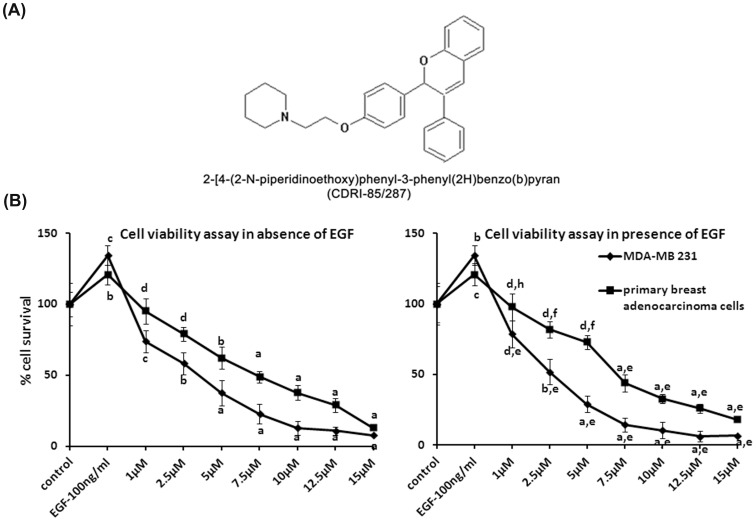
Anti-proliferative activity of CDRI-85/287 in ER-negative breast cancer cells.(A) Structure and molecular formula of CDRI-85/287. (B) CDRI-85/287 suppresses the growth of ER-negative and EGFR over-expressing breast cancer cells MDA-MB231 and primary breast adenocarcinoma cells. Cells were treated with indicated concentrations of compound for 48h in the absence or presence of 100 ng/ml of EGF. Cell viability was measured using MTT cell viability assay. The percentage of viable cells was calculated as the ratio of treated cells to the control cells. Results are expressed as mean ± SEM, n = 5. p values are a-p<0.001, b<0.01, c-p<0.05 and d-p>0.05 vs. control and e-p<0.001, f-p<0.01, g-p<0.05, h-p>0.05 vs. EGF.